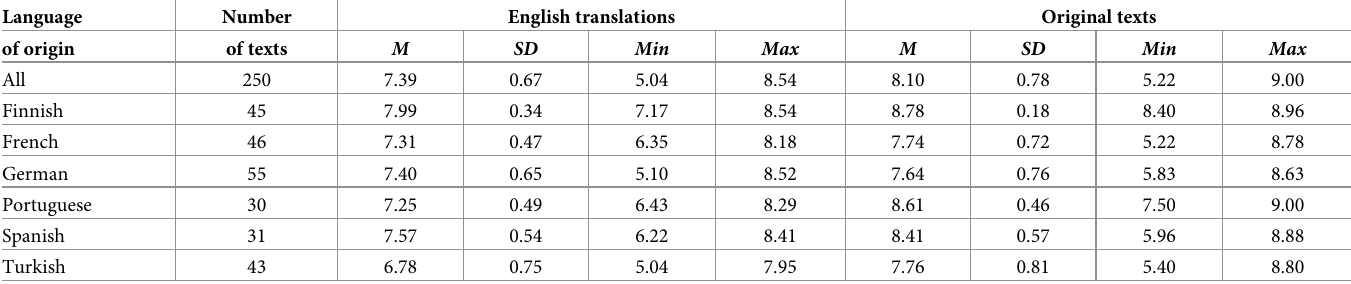
Table 6. Means, standard deviations, and minimum and maximum values of comprehensibility ratings for all texts, separately for the English translations and the original language versions. Language